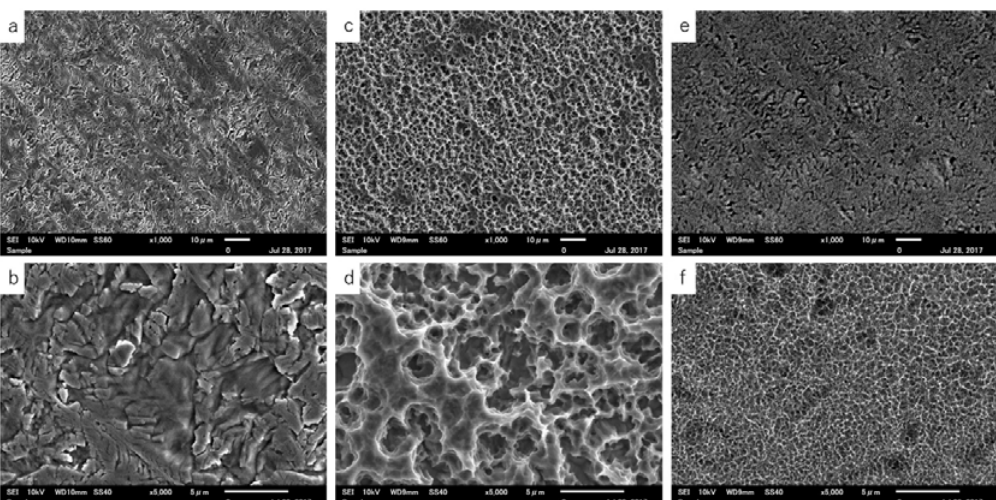
Figure 3. SEM images of each sample. Control group: ( a ) 1000 × displayed a non-uniform, rough surface; ( b ) 5000 × had grooves and indentations, but no pore structures. Acid group: ( c ) 1000 × displayed a uniform, rough surface; ( d ) 5000 × contained microscale pore structures. Alkali group: ( e ) 1000 × had a similar structure to the control group, with grooves and indentations; ( f ) 5000 × had nanoscale pore structures.